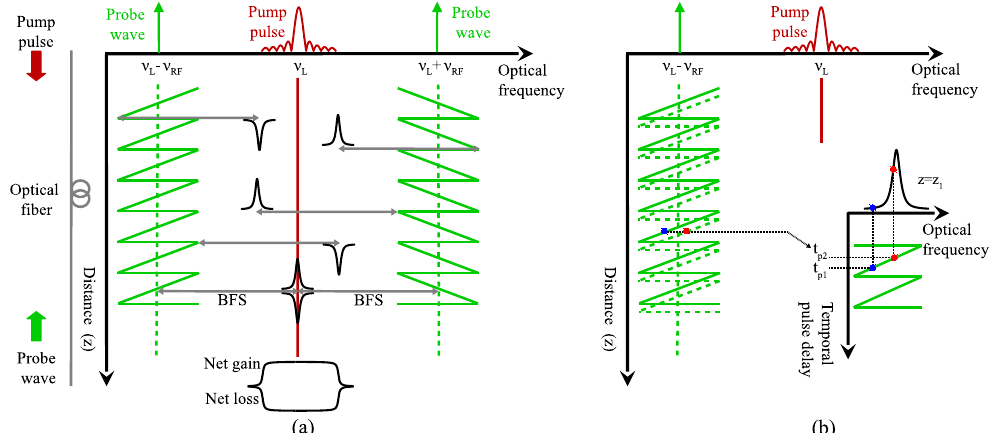
Figure 4. Fundamentals of the probe dithering technique for mitigation of second-order non-local effects: ( a ) Brillouin interaction on the pump pulse and ( b ) frequency scanning method based on the temporal delay change ( t p 1 and t p 2 ) between probe and pump